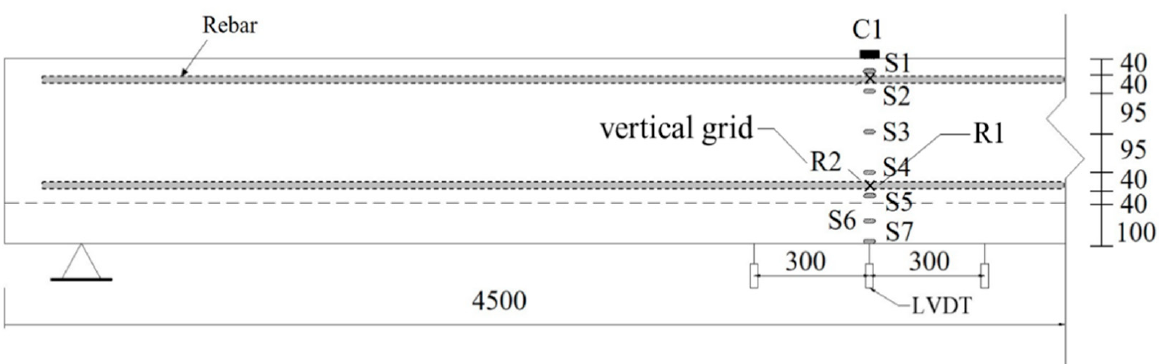
Figure 10. The locations of strain gauges.